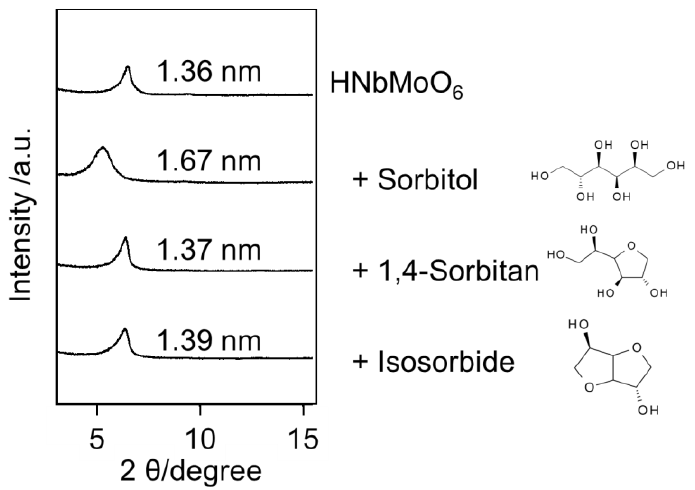
Figure 4. XRD patterns of HNbMoO 6 after immersion in water involving sorbitol, 1,4-sorbitan or isosorbide.